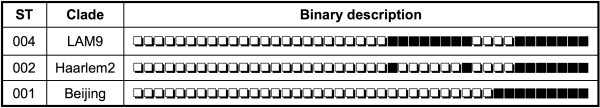
Representative spoligotyping patterns of ST 01, 02 and 04, and their associated clades. Dark squares indicate the presence of the spacer, and white squares indicate its absence (loss of spacers by a deletion mechanism). Unless they show some similarities (common absence of spacers 1–24) the three genotypes ST 01, 02 and 04 are from different families, i.e. Haarlem (absence of spacer 31 and spacers 33–36), LAM (absence of spacers 21–24 and spacers 33–36) and Beijing clades (absence of spacers 1–34) respectively. This illustrates that computation of distances on some types (for Minimum Spanning Tree construction) may be misleading.